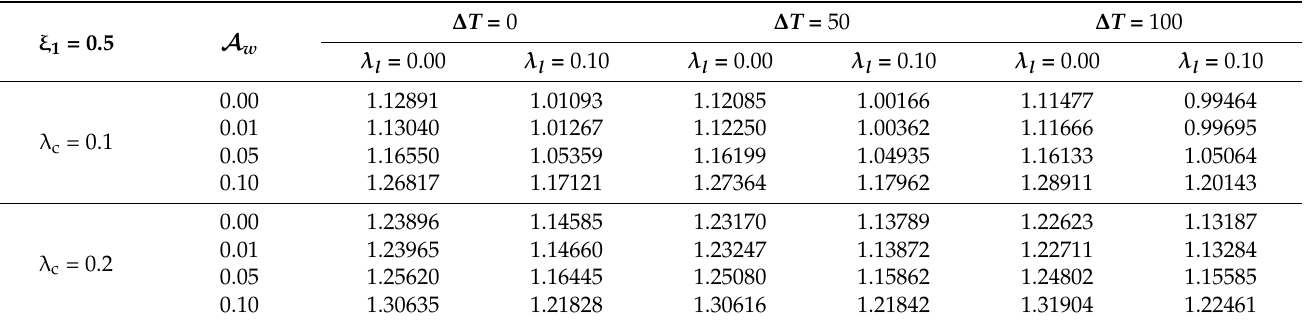
Table 13. Nonlinear dimensionless natural frequencies of porous FG clamped–clamped (C–C) nano- beam for ξ 1 = 0.5 in the case of Second-Order Hamiltonian